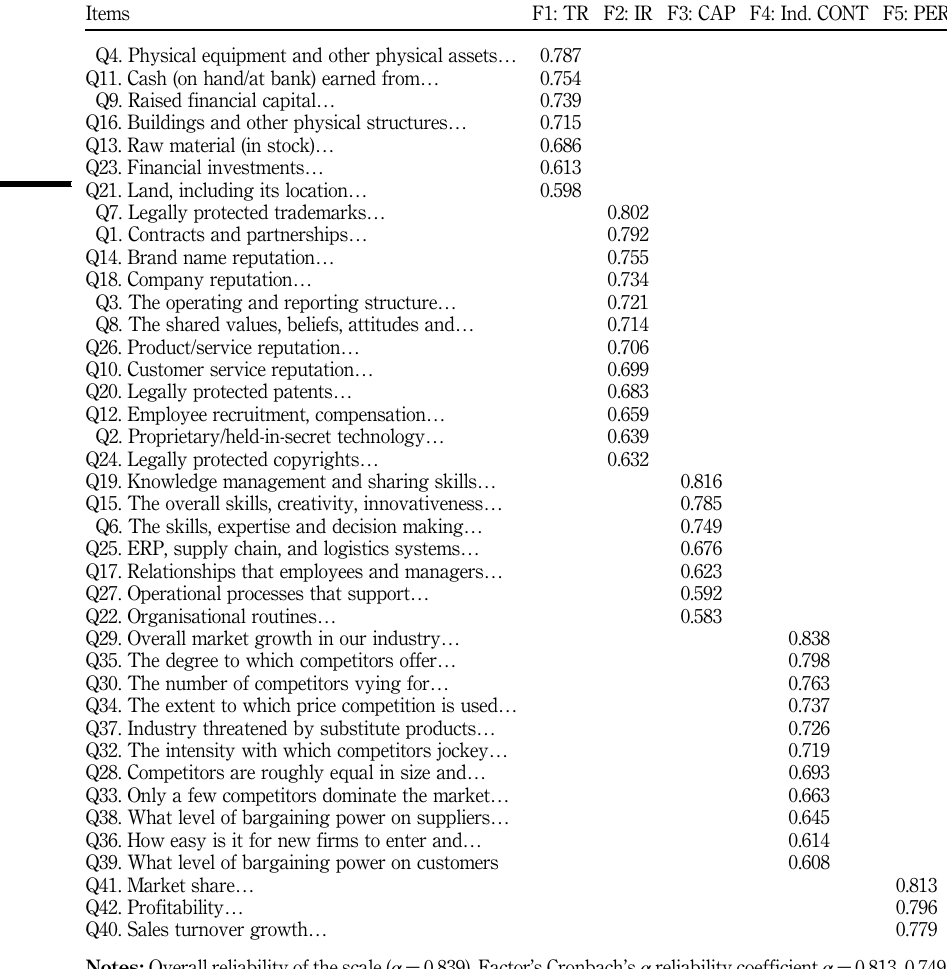
Table VI. Factor